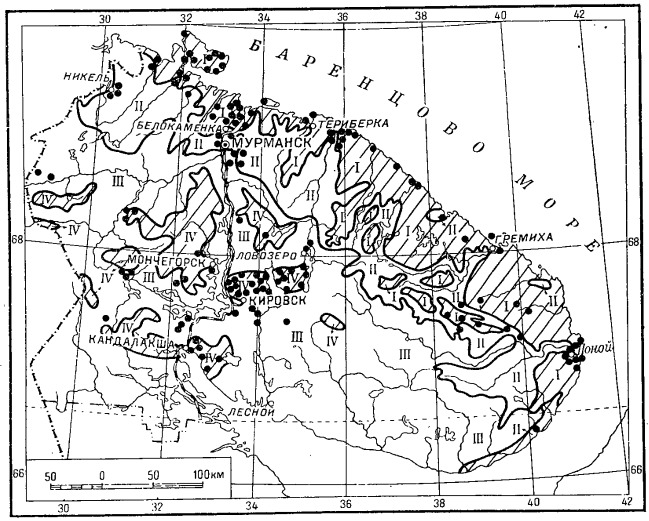
Distribution map of Phyllodoce
caerulea, original printed map (Poyarkova 1959).